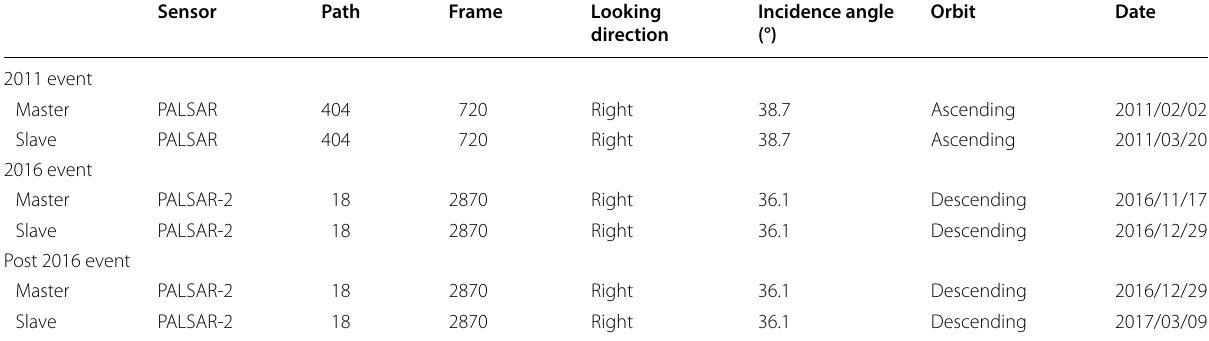
Table 1 InSAR information used in this